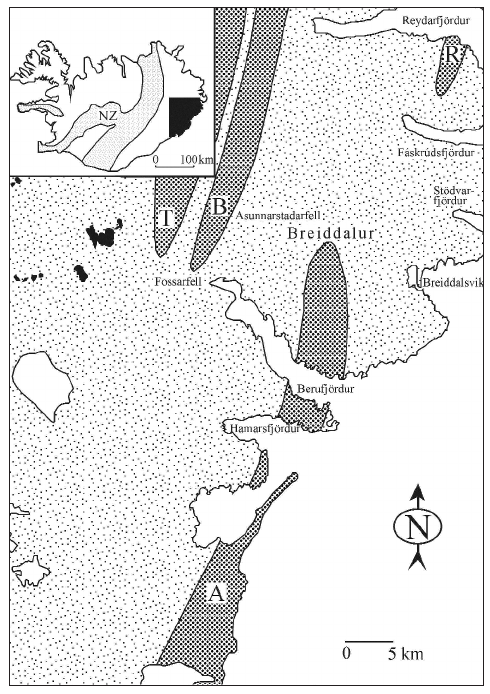
Fig. 15. Dyke swarms and associated central volca- noes (stratovolcanoes, edifices) in East Iceland. The main dyke swarms and central volcanoes indicated are Alftafjordur (A), Breiddalur (B), Reydarfjordur (R), and Thingmuli (T), ( cf. Walker, 1963 and Gud- mundsson,